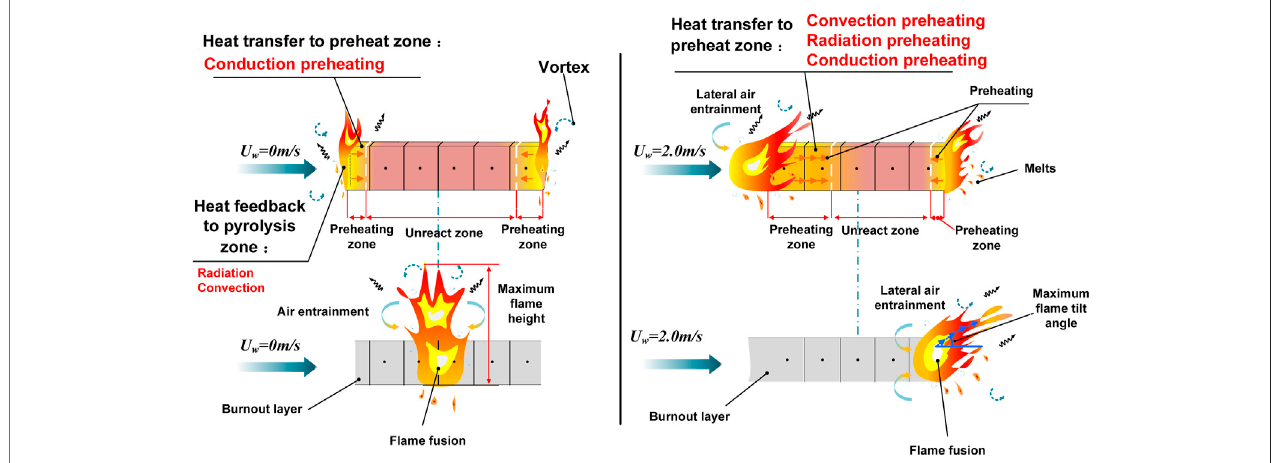
FIGURE 4 | Thermodynamics of adverse fl ame spread over the FPU foam board under various processes of heat transfer with U w (cid:1) 0 m / s and U w (cid:1) 2.0 m / s